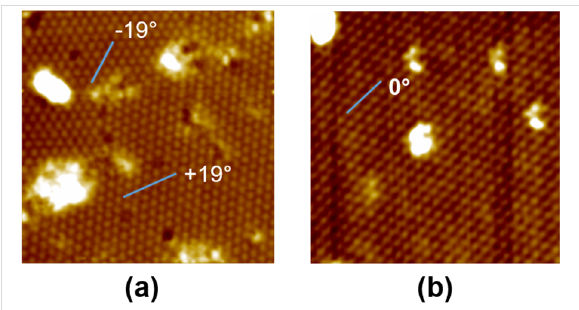
Figure 2: (a) Atomically resolved filled state STM image of a ≈ 19 × 19 nm 2 area showing two rotated hexagonal structures with √ 7× √ 7 periodicity. The angle difference between the two blue lines is ≈ 38° which corresponds to the ±19.1° orientations of the two √ 7× √ 7 domains with respect to Al(111). (b) Atomically resolved filled state STM image of a ≈ 19 × 19 nm 2 area showing a single hexagonal struc- ture with (3×3) periodicity. Both images were obtained at room temper- ature with a sample bias of − 1.20 V and a tunneling current of 200